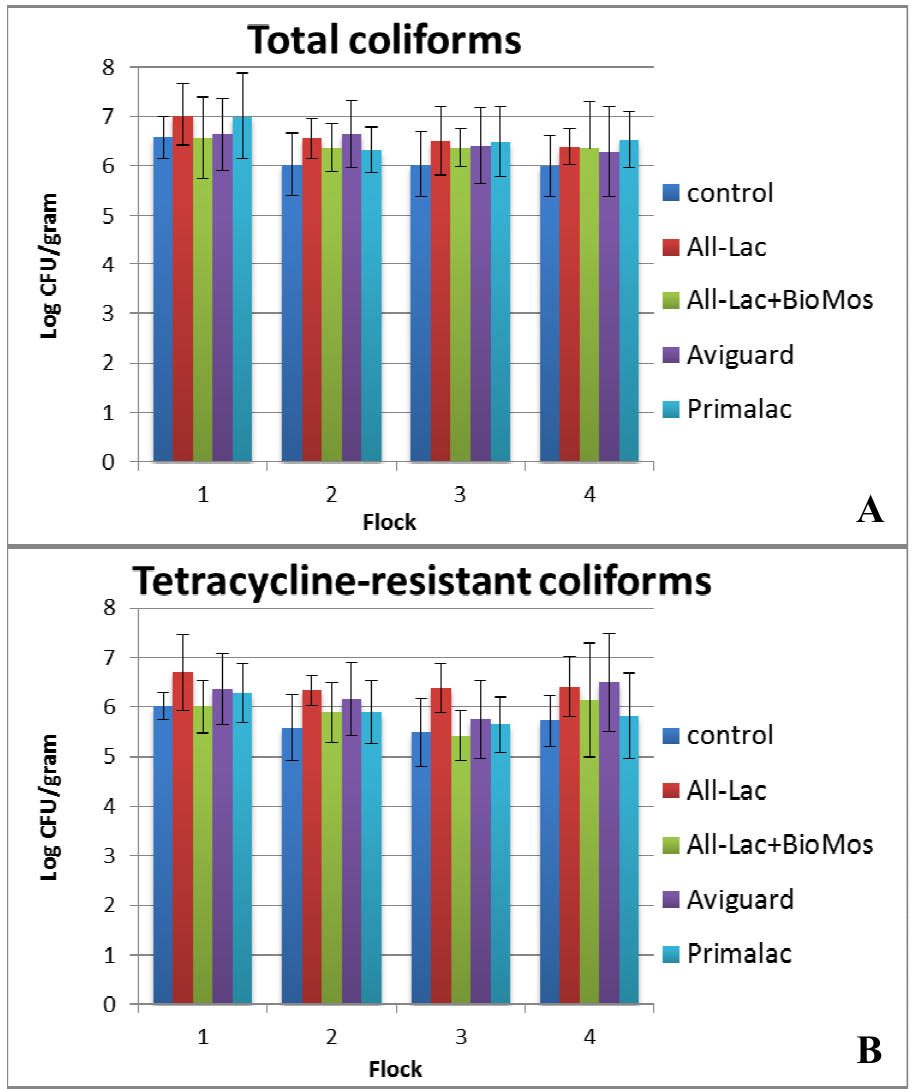
Figure 5. Log colony forming units (CFU) of coliforms (panel A ) and tetracycline-resistant coliforms (panel B ) cultured from litter collected from four sequential flocks of broiler chickens administered probiotics or prebiotics and reared in research